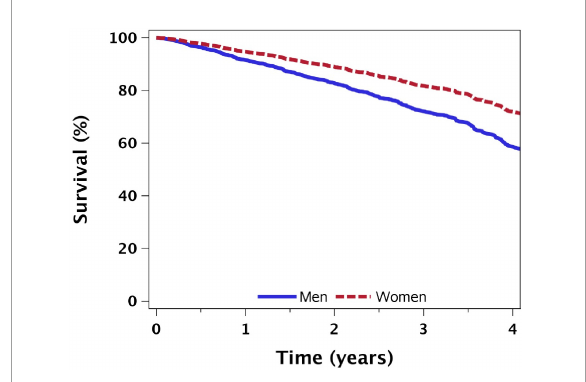
FIGURE2 Sex differences in time-to death from all causes: results from Cox proportional hazards model*. *Adjusted for study arm (control); age = 72.5 years; NYHA functional classification III; 6-min walking distance: 180 m; referred from the community, with median comorbidity score and hemoglobin baseline